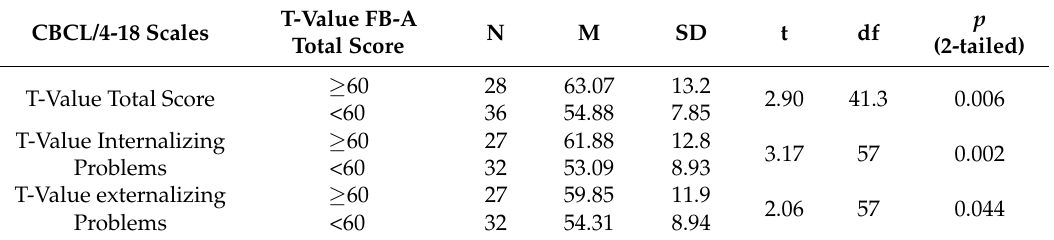
Table 3. T-Test for independent samples for functional vs. dysfunctional families regarding psychological problems of the